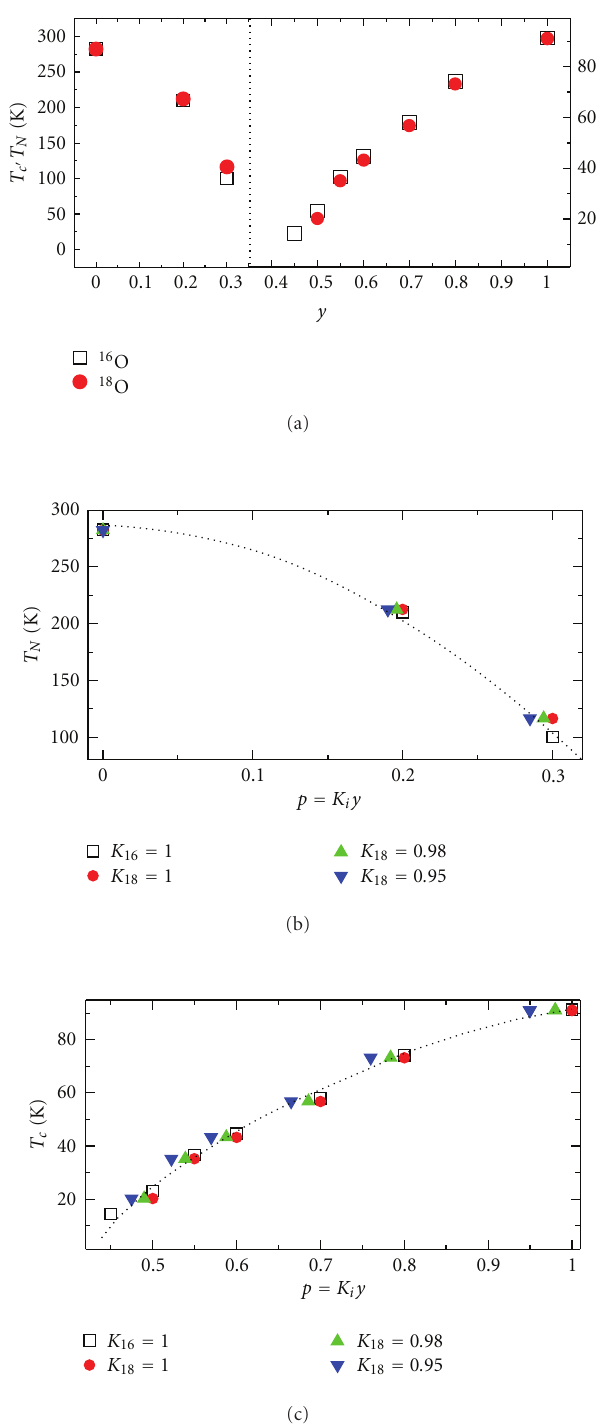
Figure 5: (a) Oxygen isotope e ff ect of T N (left) and T c (right) in Y y Pr 1 − y Ba 2 Cu 3 O 7 − δ taken from [5]. The 18 O and 16 O samples are in filled red circles and empty black squares, respectively. Figures (b) and (c) are demonstration of the IE using charge carriers density p = K i y , instead of oxygen content y . The values of K i are given in the figures. Green triangles ( K i = 0 . 98) represent reduction of 2% in the number of charge carriers in the 18 O samples compared to the 16 O sample. In this case both T N and T c are functions of p regardless of the